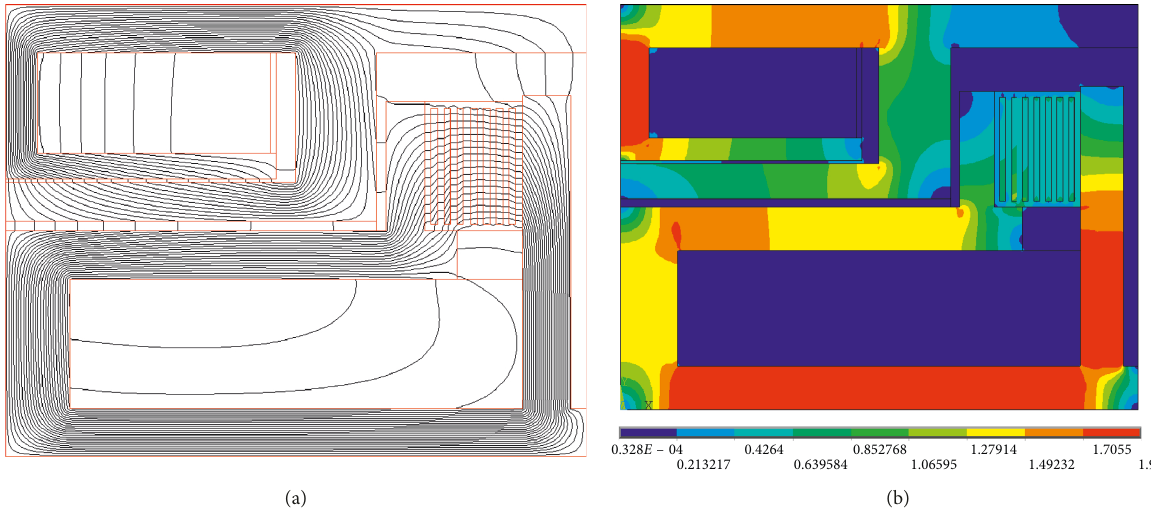
Figure 8: The simulation results of the smart isolator. (a) Distribution of the magnetic flux lines. (b) Magnetic field